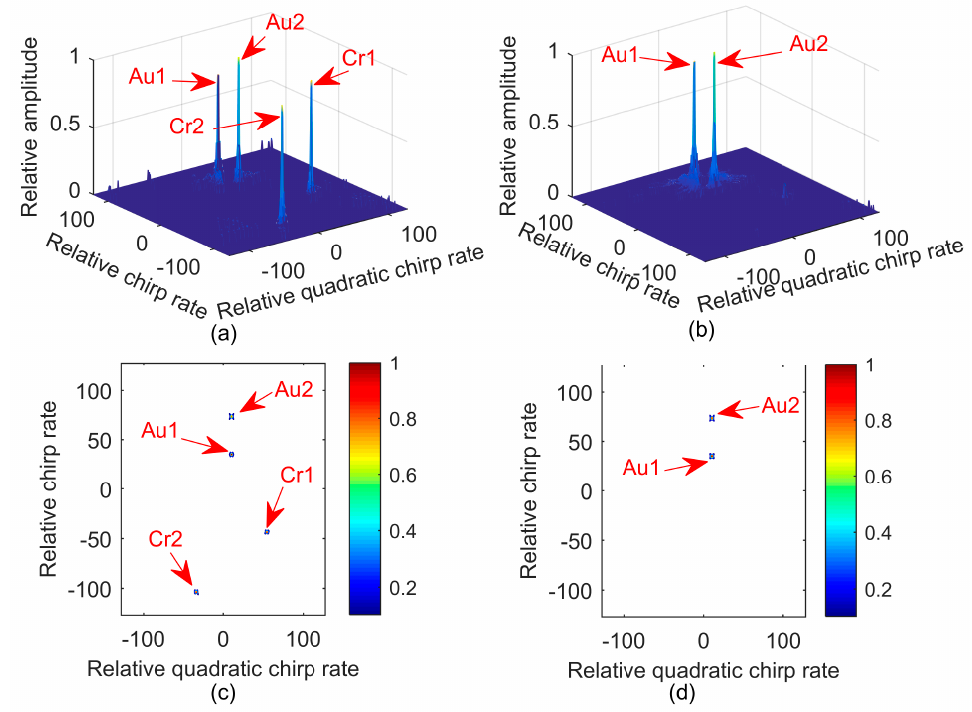
Figure 1. Simulation of Example 1. ( a ) Stereogram with MLVD; ( b ) Stereogram with 2D-PMLVD; ( c ) Contour with MLVD; ( d ) Contour with 2D-PMLVD.